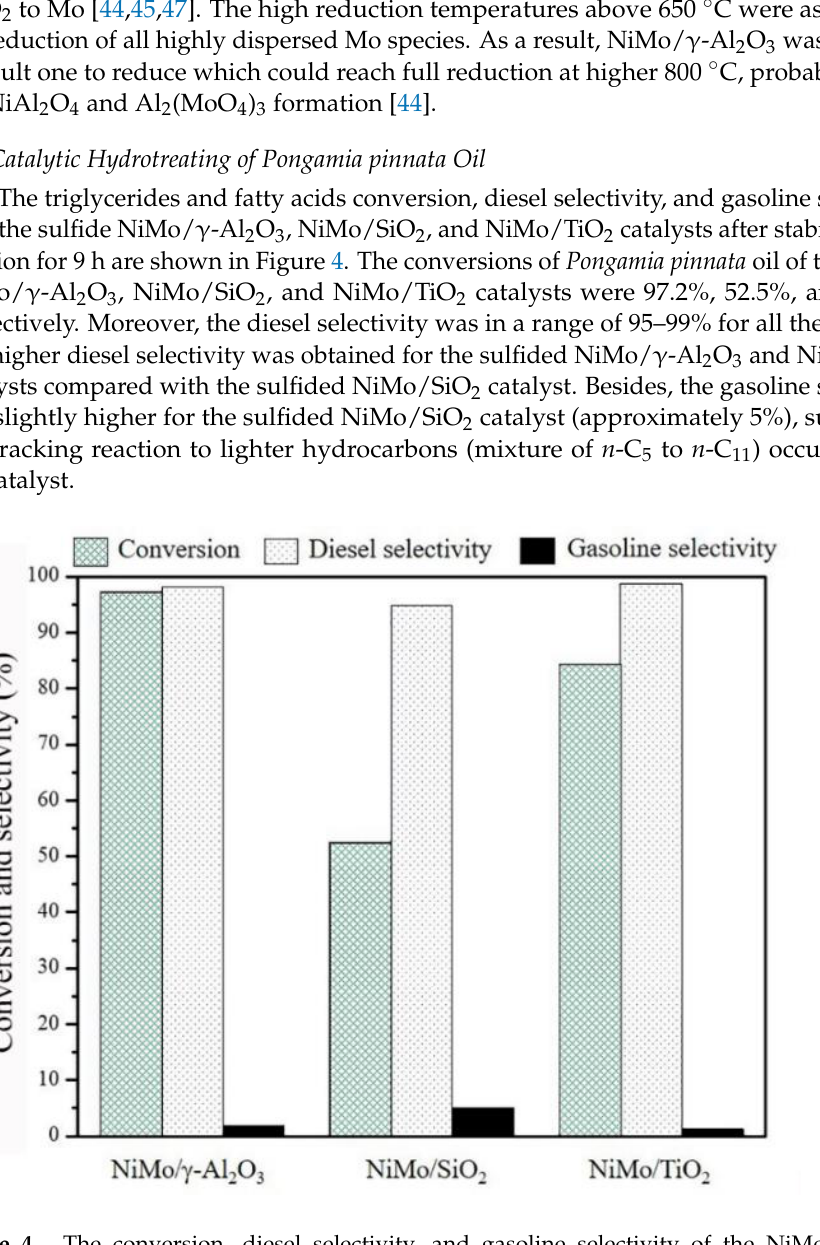
Figure 4. The conversion, diesel selectivity, and gasoline selectivity of the NiMo/γ -Al 2 O 3 , NiMo/SiO 2 , and NiMo/TiO 2 catalysts. All experiments were conducted at a temperature of 330 °C, H 2 pressure of 50 bar, WHSV = 1.5 h − 1 , and H 2 /oil ratio = 1000 cm 3 /cm 3 .